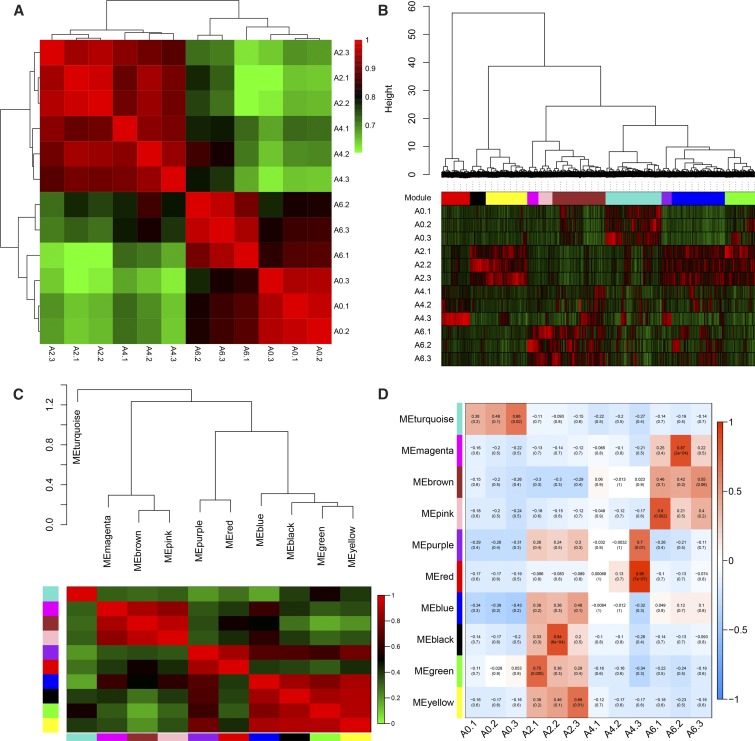
Visualization of construction of the coexpression network. (A) Heatmap of the differentiation of duplicate samples of chicken abdominal preadipocytes. The colors ranging from green to red represent Pearson correlation coefficients ranging from 0.6 to 1, indicating low to high correlations, respectively. All samples at the same differentiation stage are highly correlated, indicating reproducibility of the samples. (B) Hierarchical cluster tree (average linkage, dissTOM) of 3095 genes. The color bands provide a simple visual comparison of module assignments (branch cuttings) based on the dynamic hybrid branch cutting method. (C) Clustering of modules based on eigengenes. The colors ranging from green to red represent Pearson correlation coefficients ranging from 0 to 1, indicating low to high correlations, respectively. (D) Heatmap of correlations between module and differentiation stage. The colors ranging from blue through white to red indicate low through intermediate to high correlations, respectively. ME, the first principal component of the standardized expression profiles of a given module.